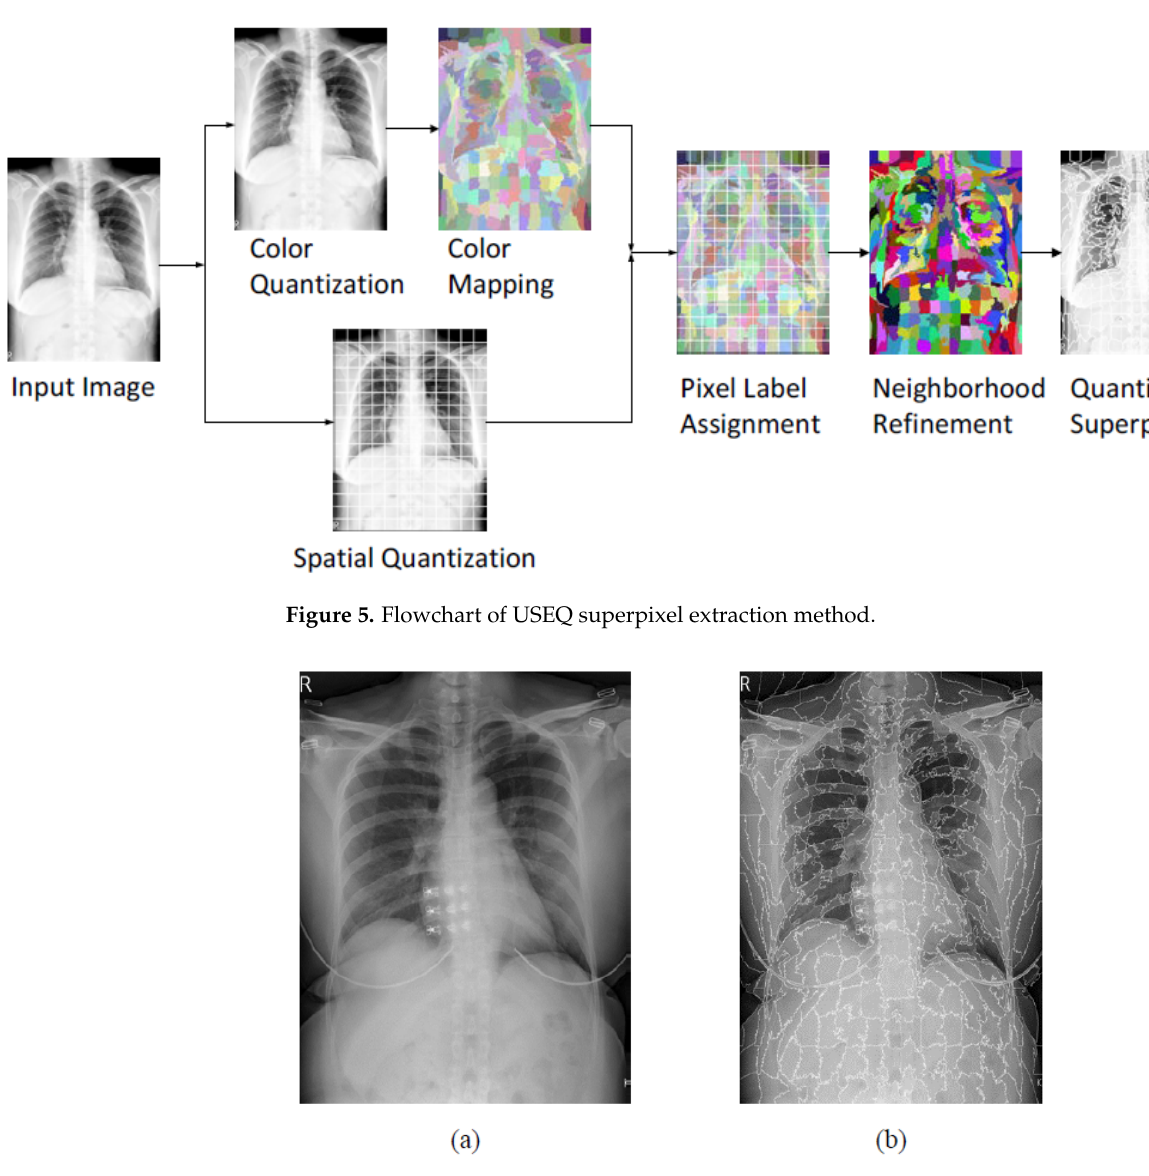
Figure 6. USEQ superpixel extraction result. ( a ) Input image. ( b ) Superpixel results.